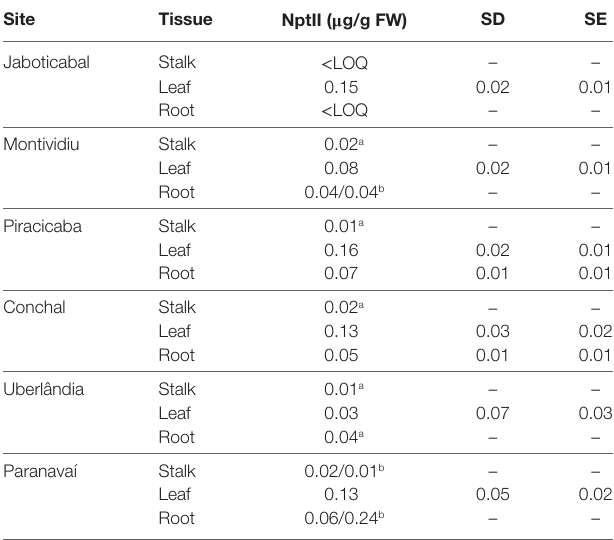
TaBle 5 | Concentration of NptII protein in tissues of CTC175-A event evaluated via ELISA ( n = 4). site